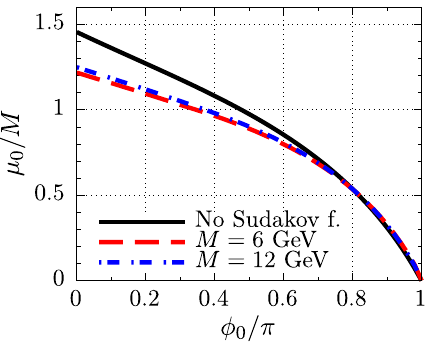
Fig. 3 Optimal scale as a function of the azimuthal angle cutoff with and without Sudakov factors. We observe that for φ 0 > 0 . 7 π the Sudakov factor does not affect much the factorization scale